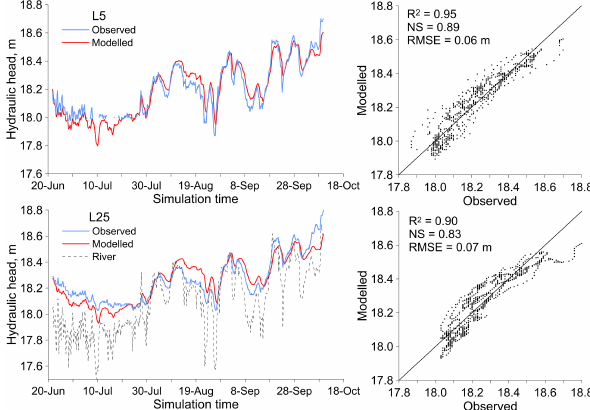
Figure 5. Hydraulic head at observation wells L5 (above) and L25 and the river (below) compared with the simulated results using cal- ibrated parameters (see Table